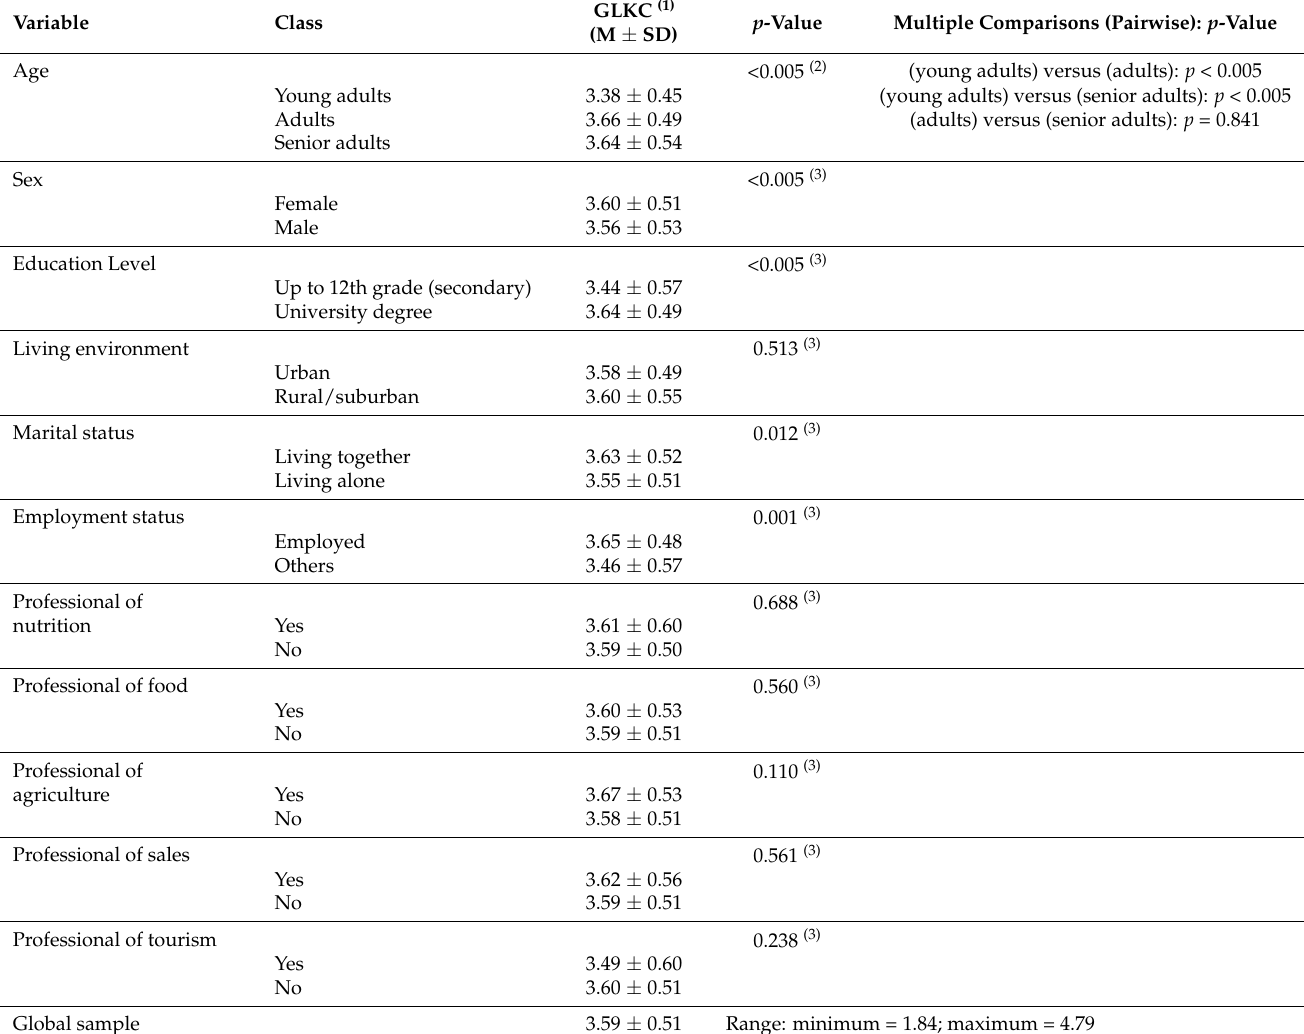
Table 1. Level of knowledge according to the sociodemographic